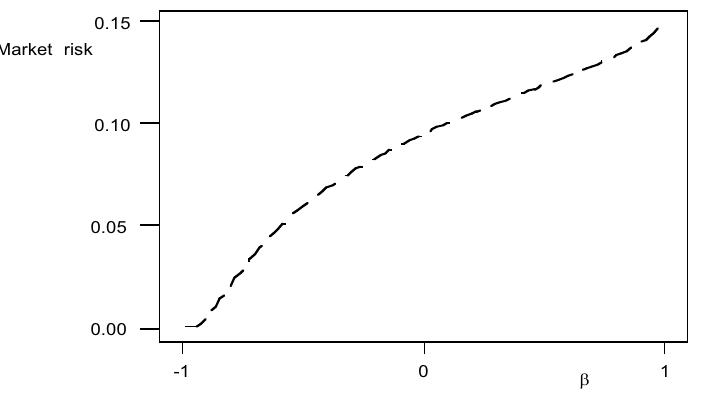
Figure 2 – Plot of the market risk measure of Equation 3 as a function of the β of the asset consid- ering a cut-off return of - 0.5 (expressed in standardized scores) for both the portfolio and